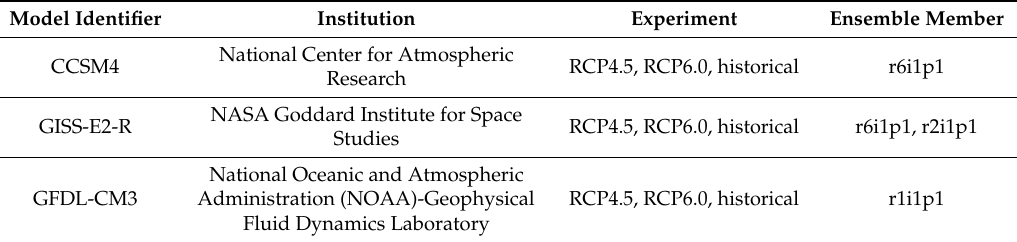
Table 3. Selected models for Upper Choctawhatchee subbasin future climate projections.